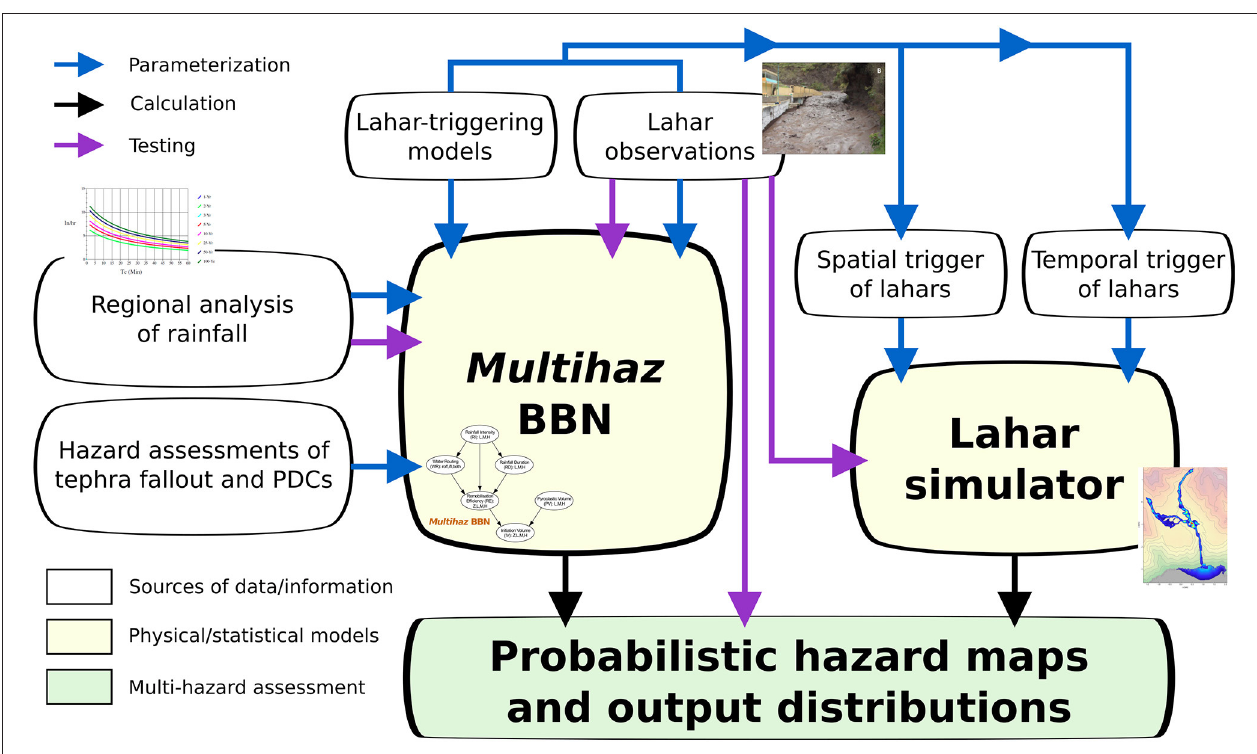
FIGURE 11 | Summarizing schematic of the presented framework for probabilistic volcanic multi-hazard assessment with focus on rain-triggered lahars (see Figure 1 ), including some possible future research directions to improve such multi-hazard assessment (or similar ones). Observations coming from the regional rainfall phenomenology and the lahar events at the volcano of interest can be used to test the assessments made by Multihaz (purple arrows). Moreover, the lahar observations can serve to test the performance of the lahar simulator and, if there is sufficient data, the probabilistic multi-hazard assessment. Likewise, different sources of information (white boxes) may be utilized to refine the parameterization of the whole multi-hazard framework, including the temporal trigger of lahars, which is not treated in our study (see text for more details). Graph of regional rainfall and lahar-observation image modified from https://thecriticalflow.wordpress.com and Jones et al. (2015),